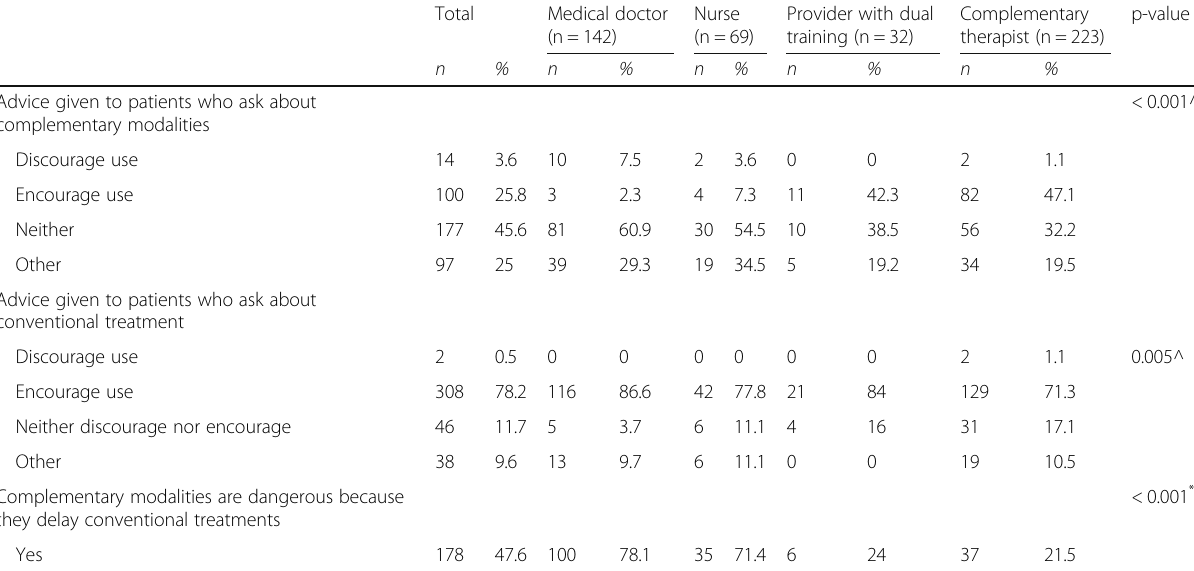
Table 4 Attitudes and knowledge about indirect risk situations ( n = 466) a